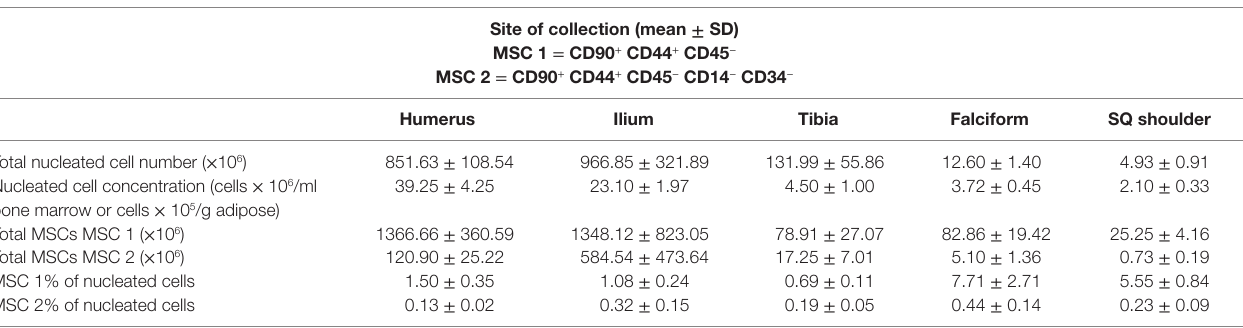
TaBle 2 | numbers and concentrations of cells.